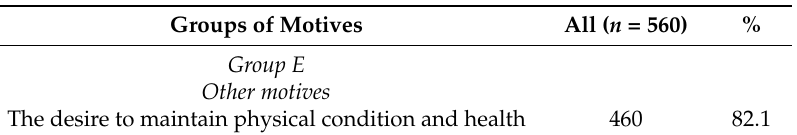
Table 4. Other motives ( n = 560).